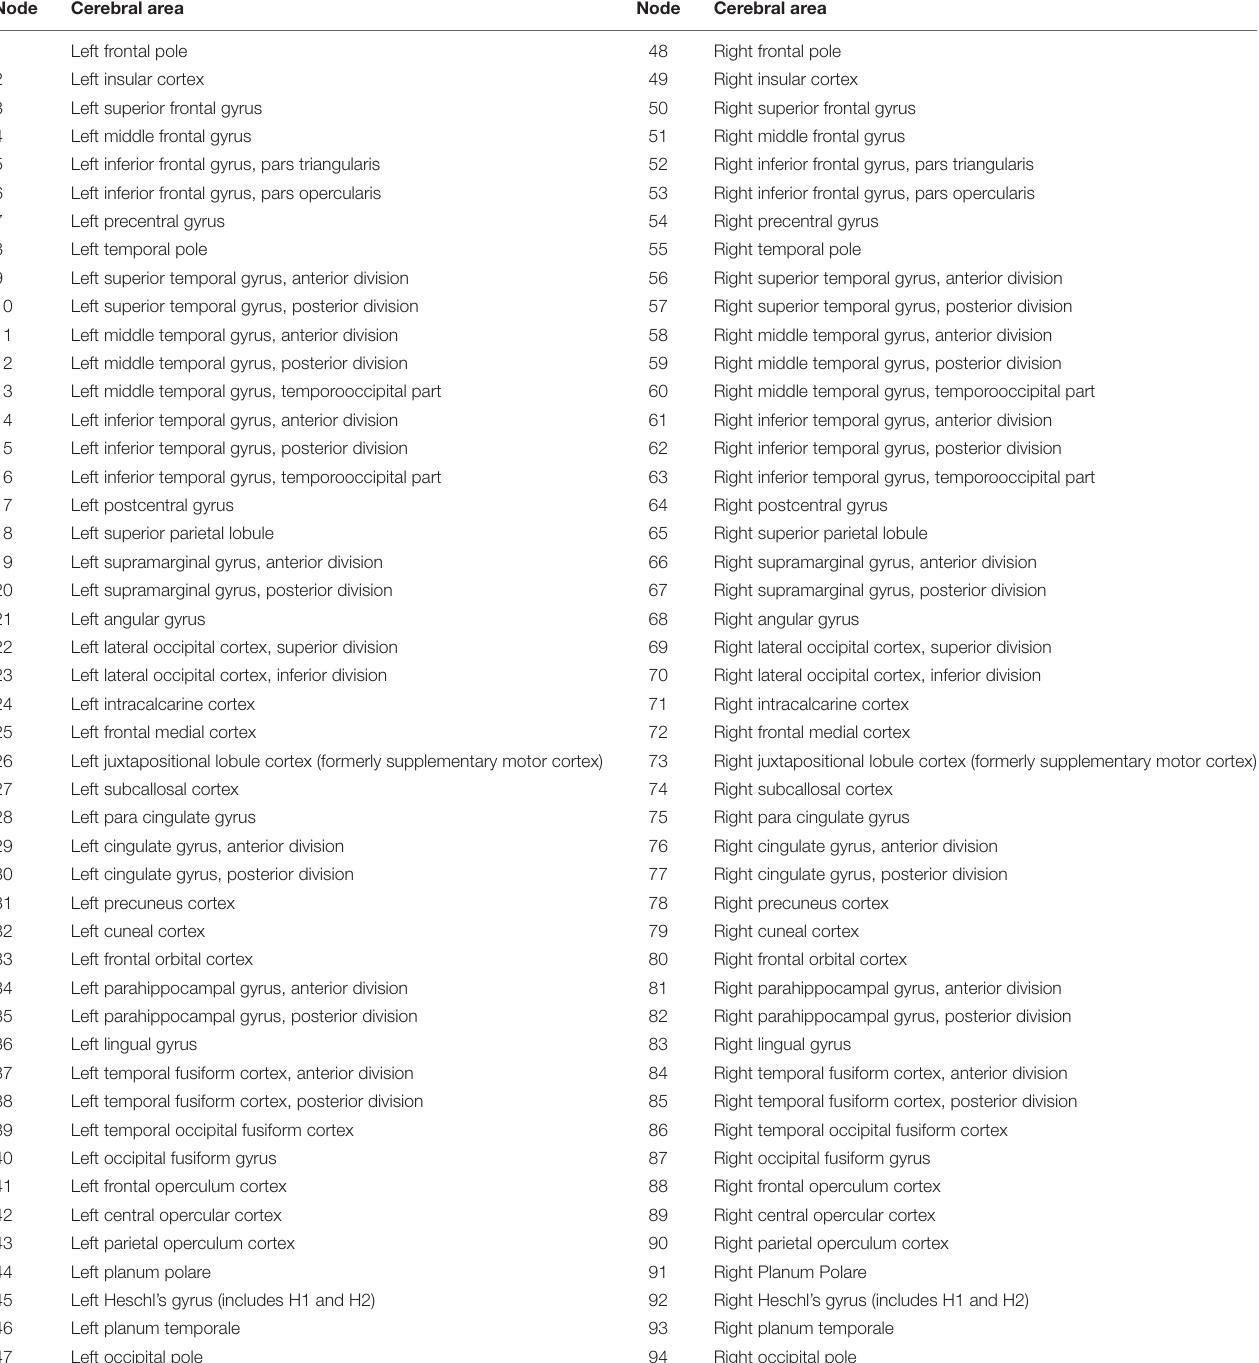
TABLE 1 | Harvard–Oxford Atlas (HOA) nodes and corresponding cerebral